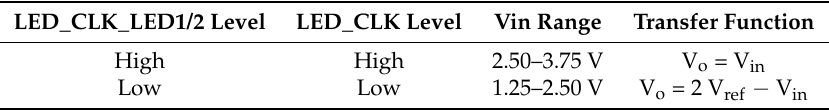
Table 1. The function configuration of ADG733.